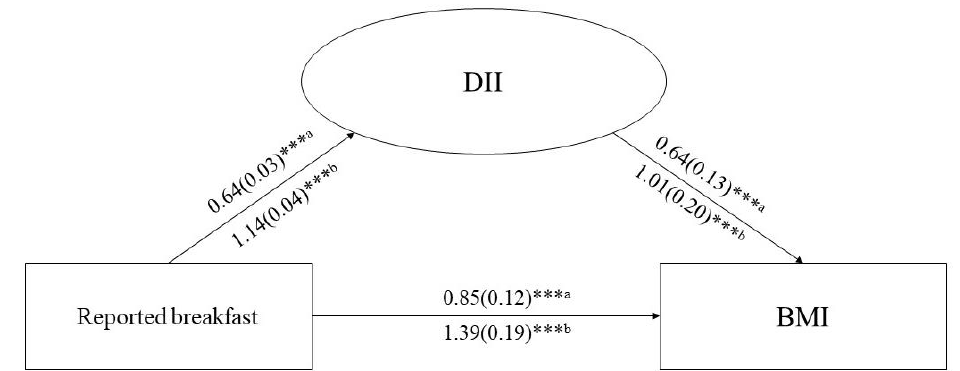
Figure 1. Regression results of the mediation analysis models. Notes: Exposure: Reported